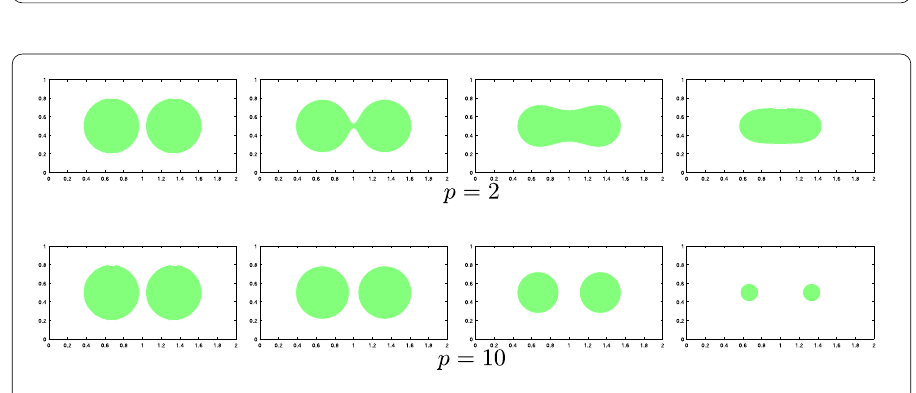
Figure 8 Evolution of φ ( x , y , t ) with (cid:4) = 0.02, (cid:7) x = (cid:7) y = 1 400 (cid:7) t , 2000 (cid:7) t , and 4000 (cid:7) t (from left to